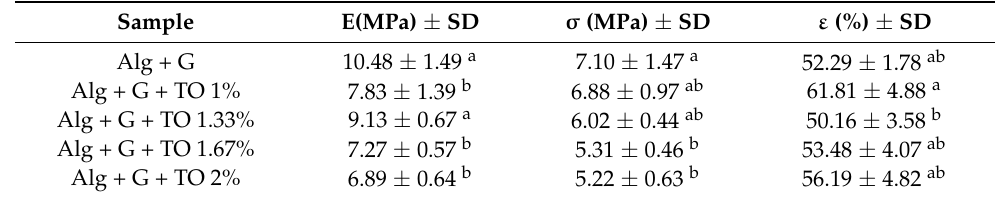
Table 3. Young’s modulus (E, MPa), stress at break ( σ , MPa), strain at break ( ε , %) of the studied samples; SD means standard deviation.